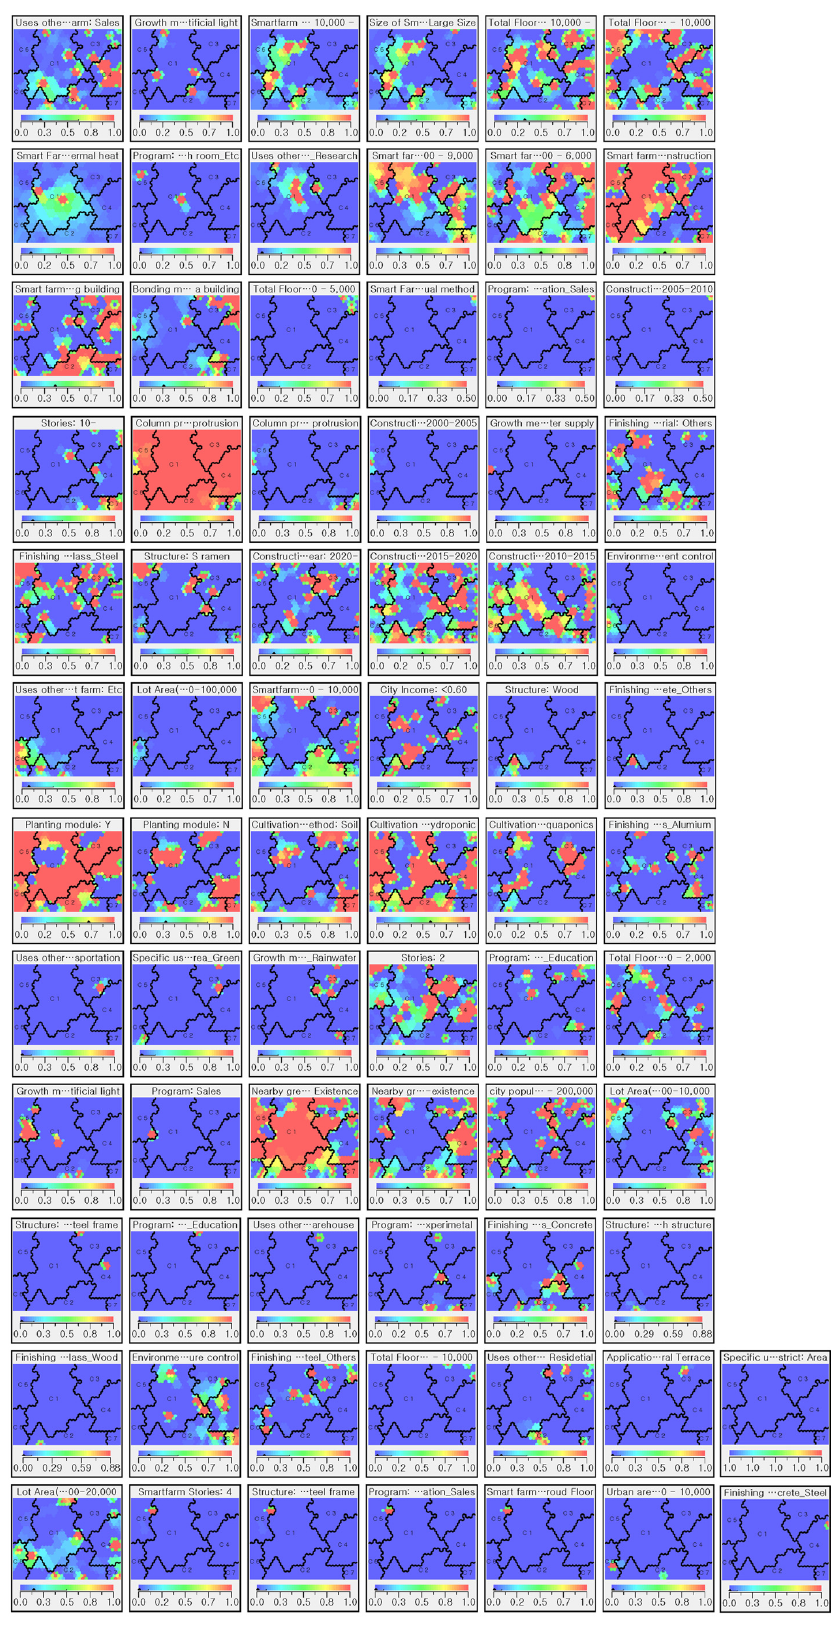
Figure A8. Plane Map for All